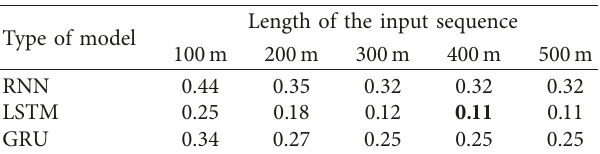
Table 5: KL divergence of the deep learning models with different lengths of input